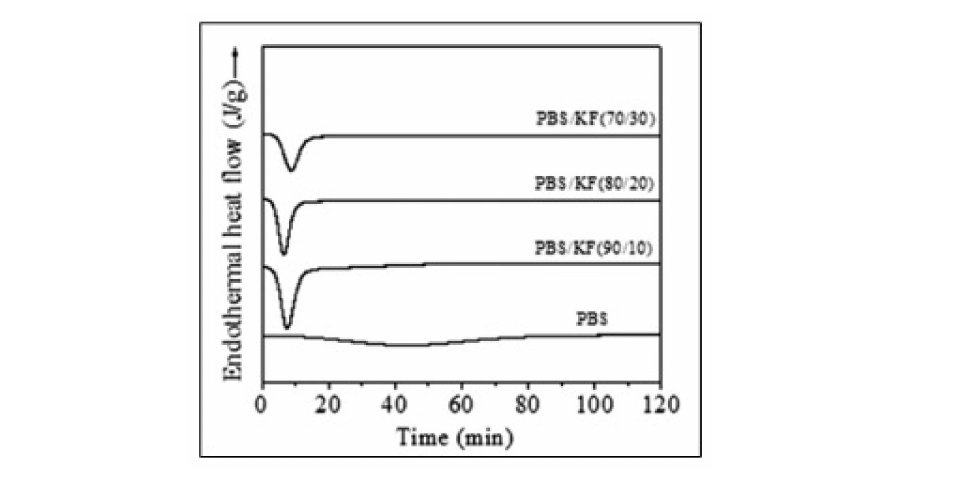
Figure 13. DSC curves of PBS and PBS/kenaf fiber (KF) composites isothermally melt-crystallized at 100 ◦ C [86]. Adapted with permission from Pinho et al. (2009).